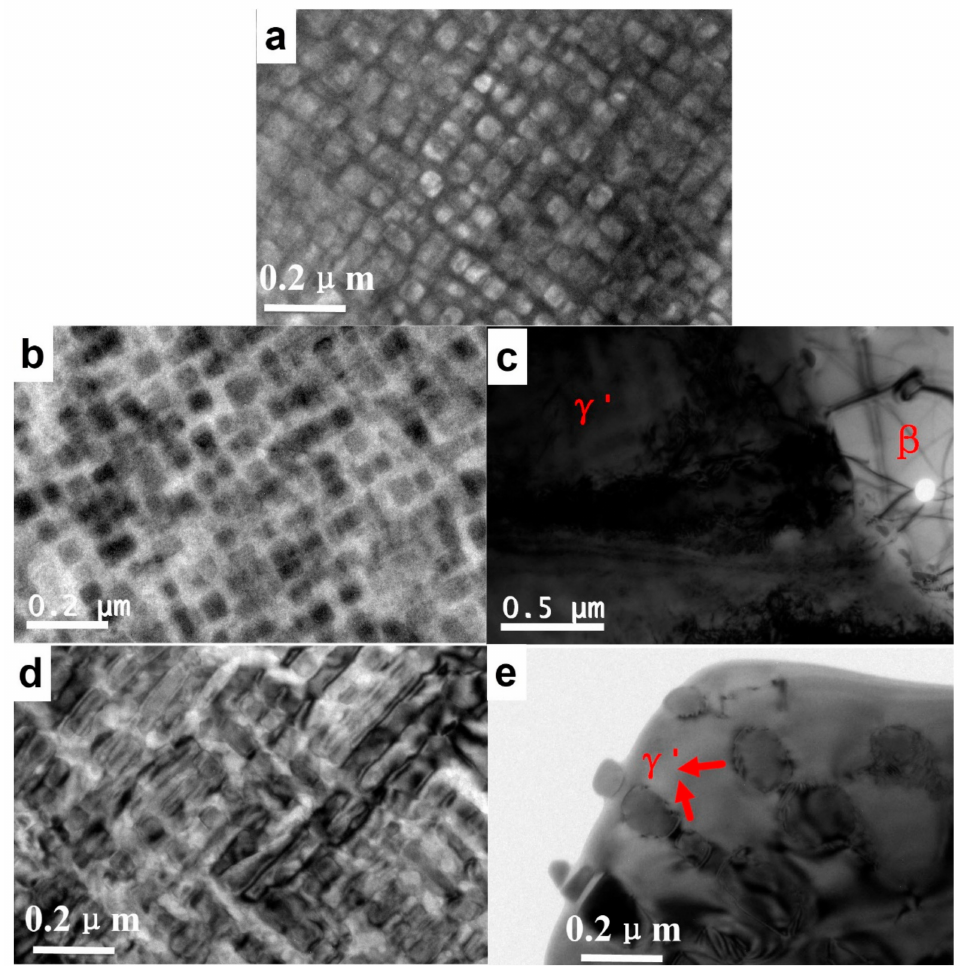
Figure 5. TEM micrographs of the γ ’ phase for Inconel 783 alloy bolts with di ff erent aging temperatures and times: ( a ) as-initial bolt, ( b ) 650 ◦ C—1000 h, ( c ) 650 ◦ C—20,000 h, ( d ) 700 ◦ C—1000 h and ( e ) 700 ◦ C—20,000 h,